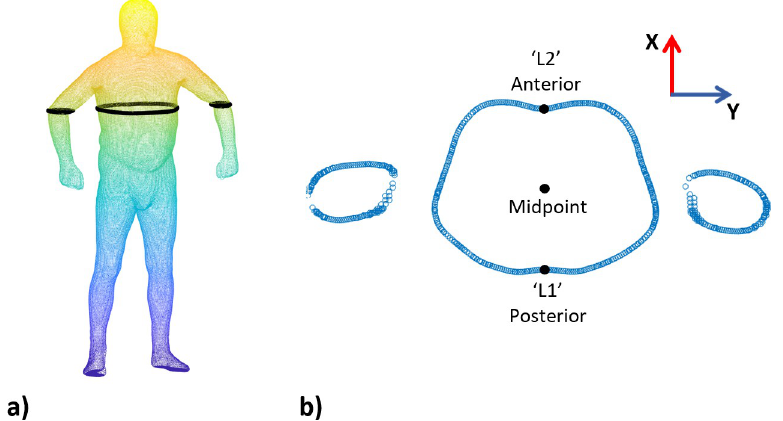
Fig 1. Identification of anterior and posterior torso landmarks. (a) Extracted data points from 3D image, (b) Identification of anterior and posterior landmarks within point slice